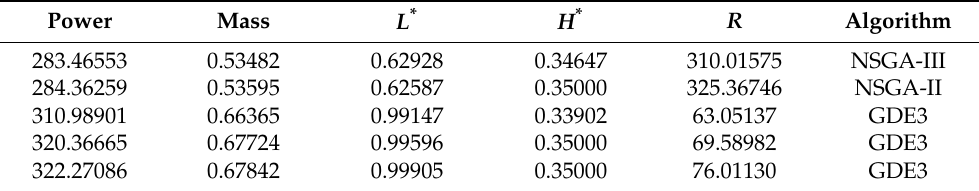
Table 5. Some solutions belonging in optimal Pareto front. Power Mass L * H * R